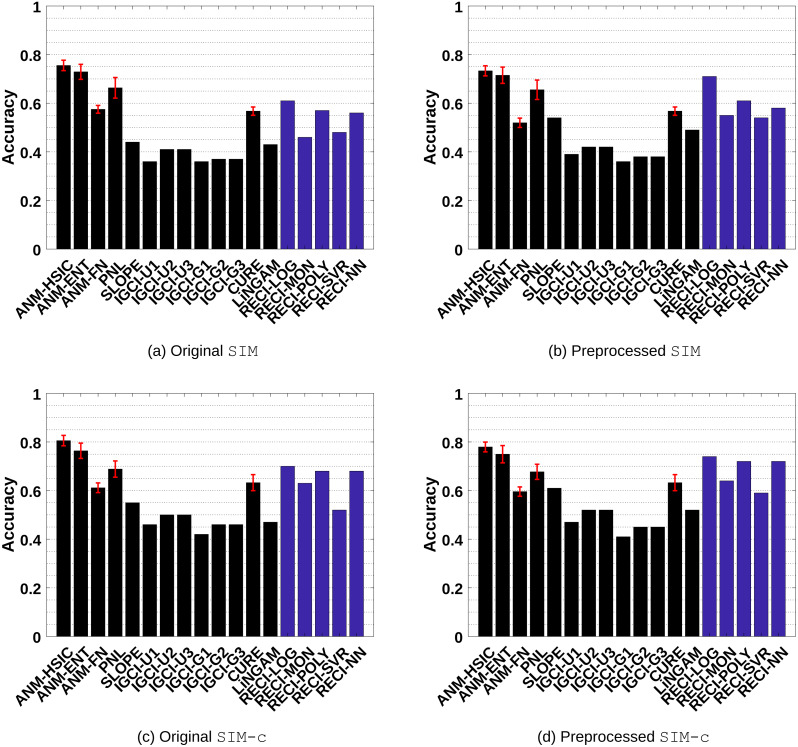
Evaluation results of all methods in the SIM and SIM-c data sets.(A) and (C) show the results of the evaluations in the original data and (B) and (D) the results in the preprocessed versions where low-density points were removed.